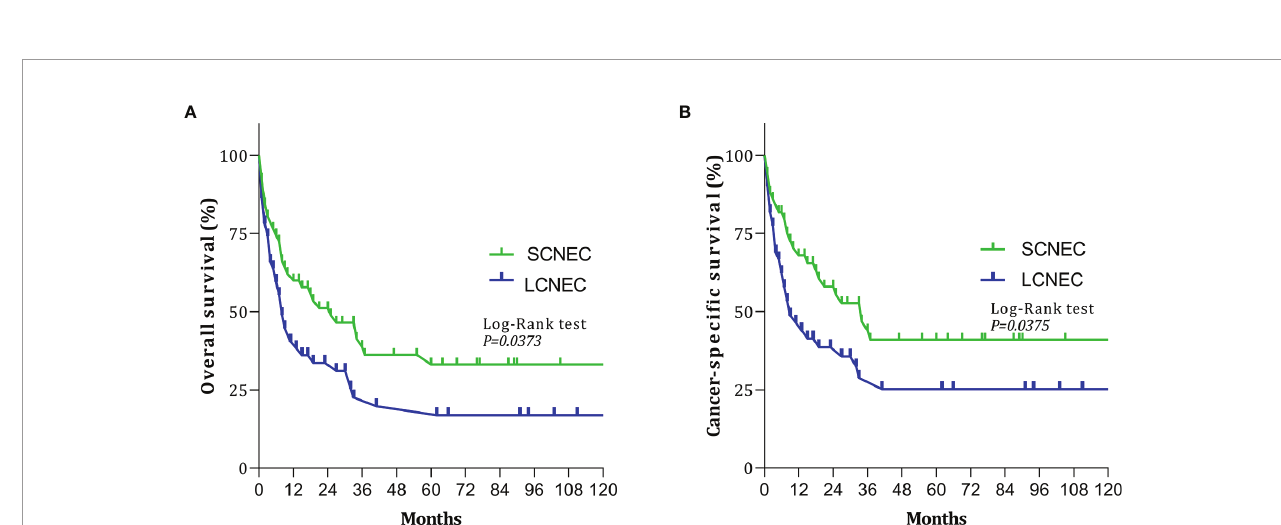
FIGURE 2 | Survival curves for patients with small-cell neuroendocrine carcinoma (SCNEC) and large-cell neuroendocrine carcinoma (LCNEC): (A) overall survival (OS); (B) cancer-speci fi c survival